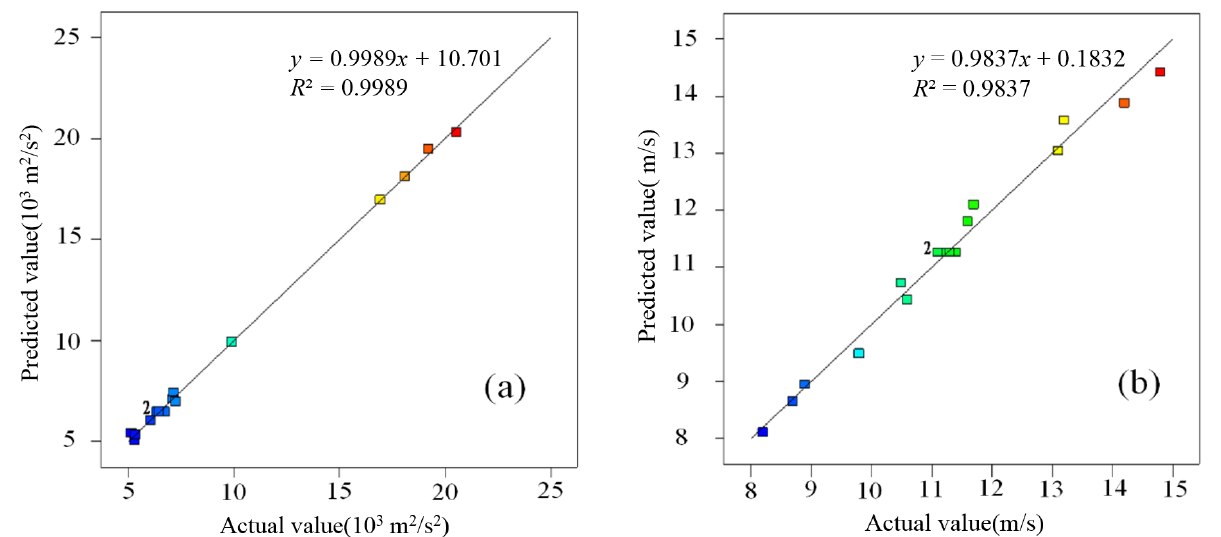
Figure 7. Analysis of predicted and actual values of specific power consumption and throwing speed: ( a ) Specific power consumption; ( b ) Throwing speed.